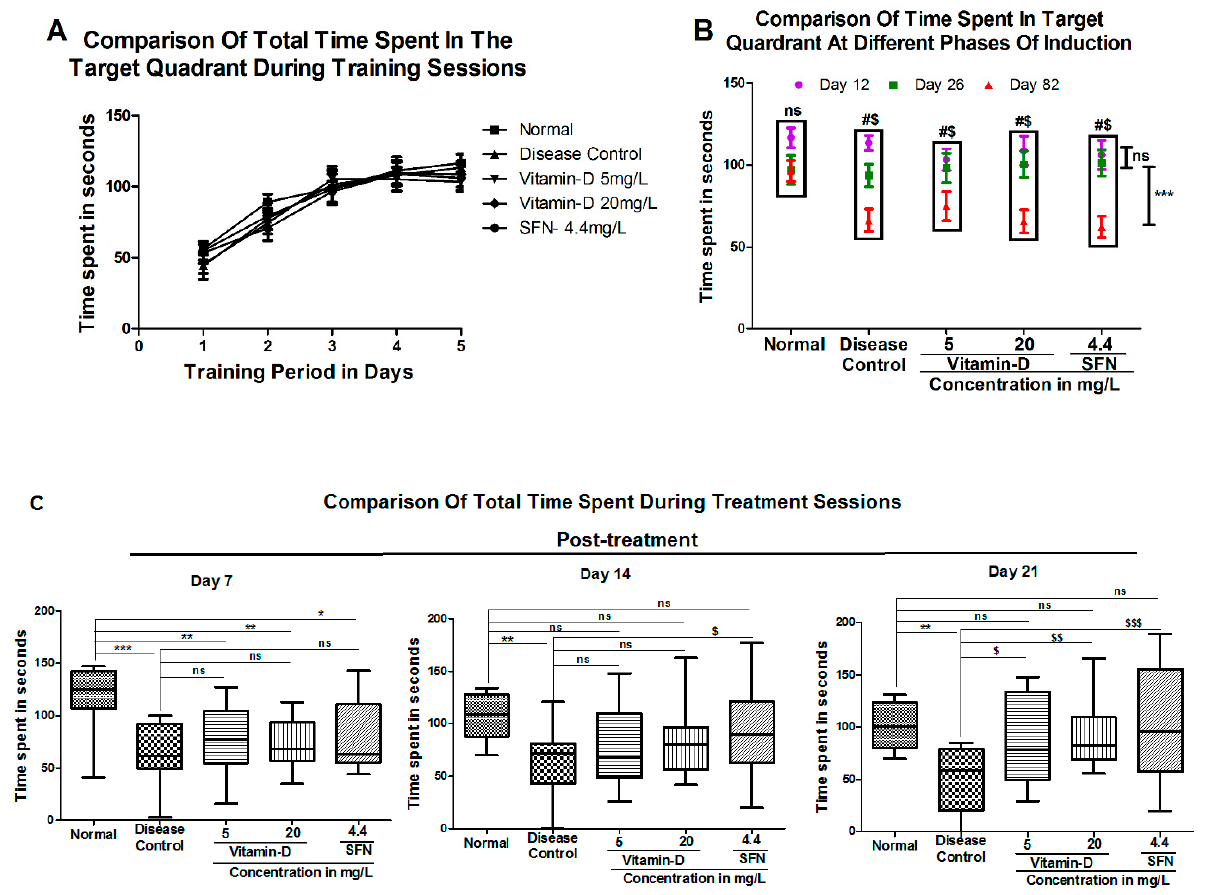
Figure 3. Vitamin D and SFN Treated Zebrafish Exhibited Similar Favorable Chamber Residing Time as That of Control Fish: ( A ) A 5-days training increased the residing time of zebrafish in favorable chamber. Time spent (in seconds) by zebrafish ( n = 15) in the deep square chamber has increased gradually during the 5-days of training session. No difference in the favorable chamber residing time was observed among the experimental groups ( p > 0.05 by One-Way ANOVA). ( B ) Hyperglycemic zebrafish spent much lesser time in the favorable chamber compared with normal zebrafish. A significant decrease in the time spent was observed in zebrafish with hyperglycemia compared with the one with no hyperglycemia, in particular at day 82 (Red triangles; p < 0.05 by One-Way ANOVA, Tukey’s post-hoc test). The difference is reflected in all the experimental groups. The data represents mean ( n = 15) ± SEM. “***” Represents significance between day 12 and day 82 with p < 0.001, “#” Represents significance in time spent between day 26 and day 82 at p -value < 0.05, “$” Represents significance in time spent compared with normal control group at day 82 with p -value < 0.05. ( C ) Treatment of hyperglycemic zebrafish with vitamin D or SFN increased the time spent in favorable chamber. Treatment of hyperglycemic zebrafish enhanced the time spent (in seconds) in a favorable chamber in the T-maze. The “***”, “**” & ‘’*’’ in (C) represents a significant difference compared with normal control with p < 0.0001, p < 0.001 & p < 0.05 respectively, and $$$, $$ & $ represents significant difference compared with disease control with p < 0.0001 p < 0.001 & p < 0.05 respectively. “ns” represents “non significance”.